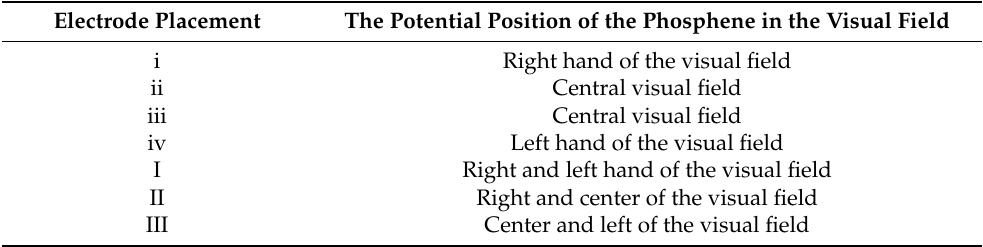
Table 2. The potential location of the phosphene in each electrode used in the second simulation.